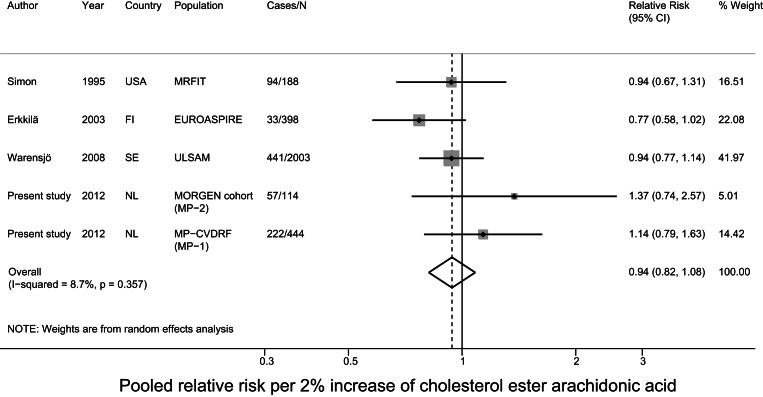
Pooled relative risk of cholesterol ester arachidonic acid and CHD risk.